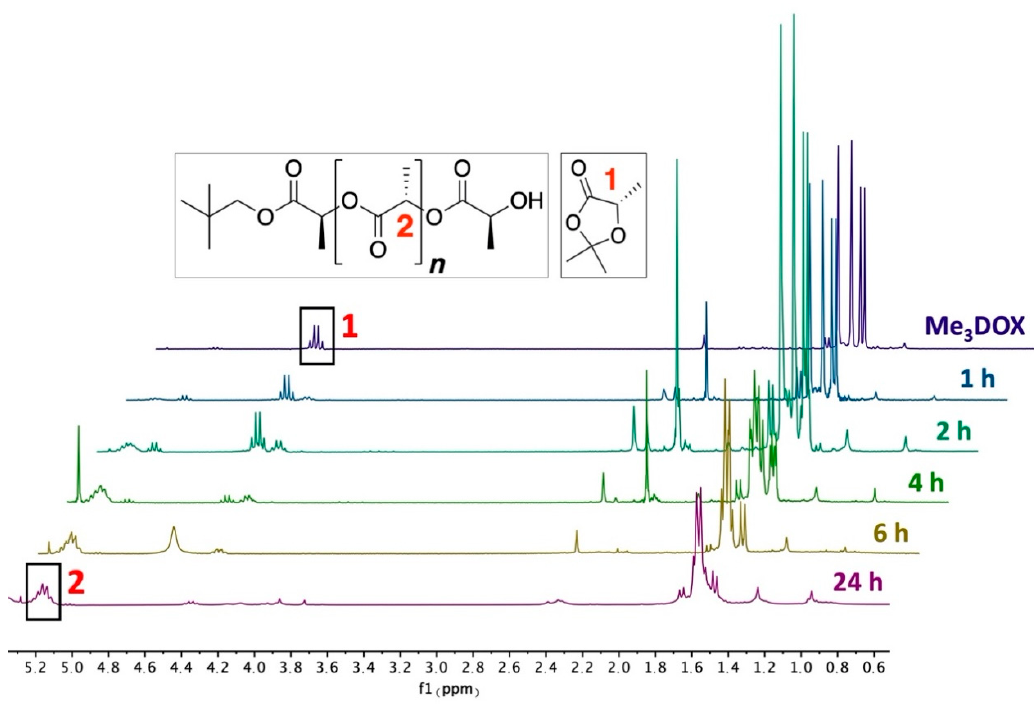
Figure 4. Stacked 1 H NMR spectra of samples taken from the Me 3 DOX polymerization reaction, compared with the monomer’s 1 H NMR spectrum.